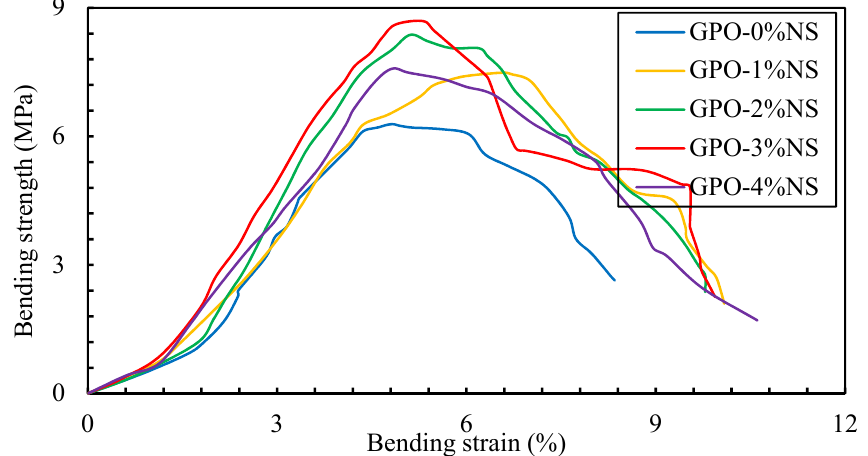
Figure 10. Variations in the bending stress behavior of fiber-reinforced pastes with different amounts of NS.